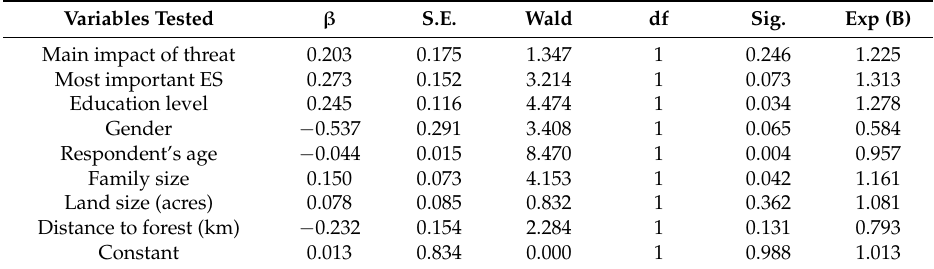
Table 3. Results of logistic regression model